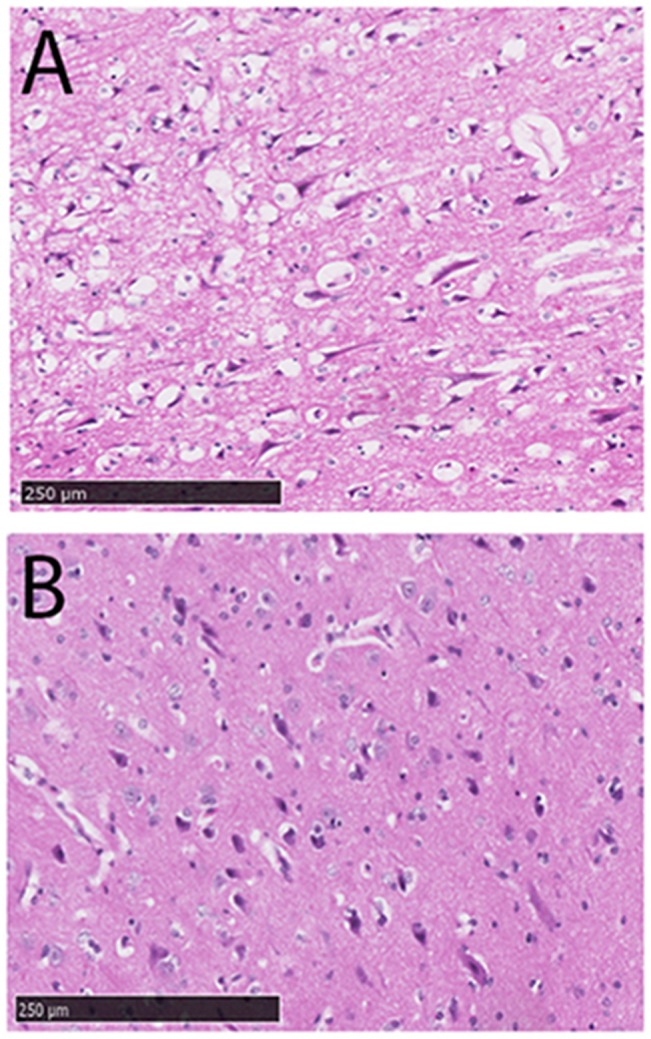
Histopathology for H&E.The infarct was evident as a region of tissue pallor, charcterised by extensive cell injury/death and tissue vacuolation (A). The was selective cell sparing and cell injury/loss within the penumbral tissue (B). n = 8 shams, n = 12 transient MCAO, n = 10 permanent MCAO.